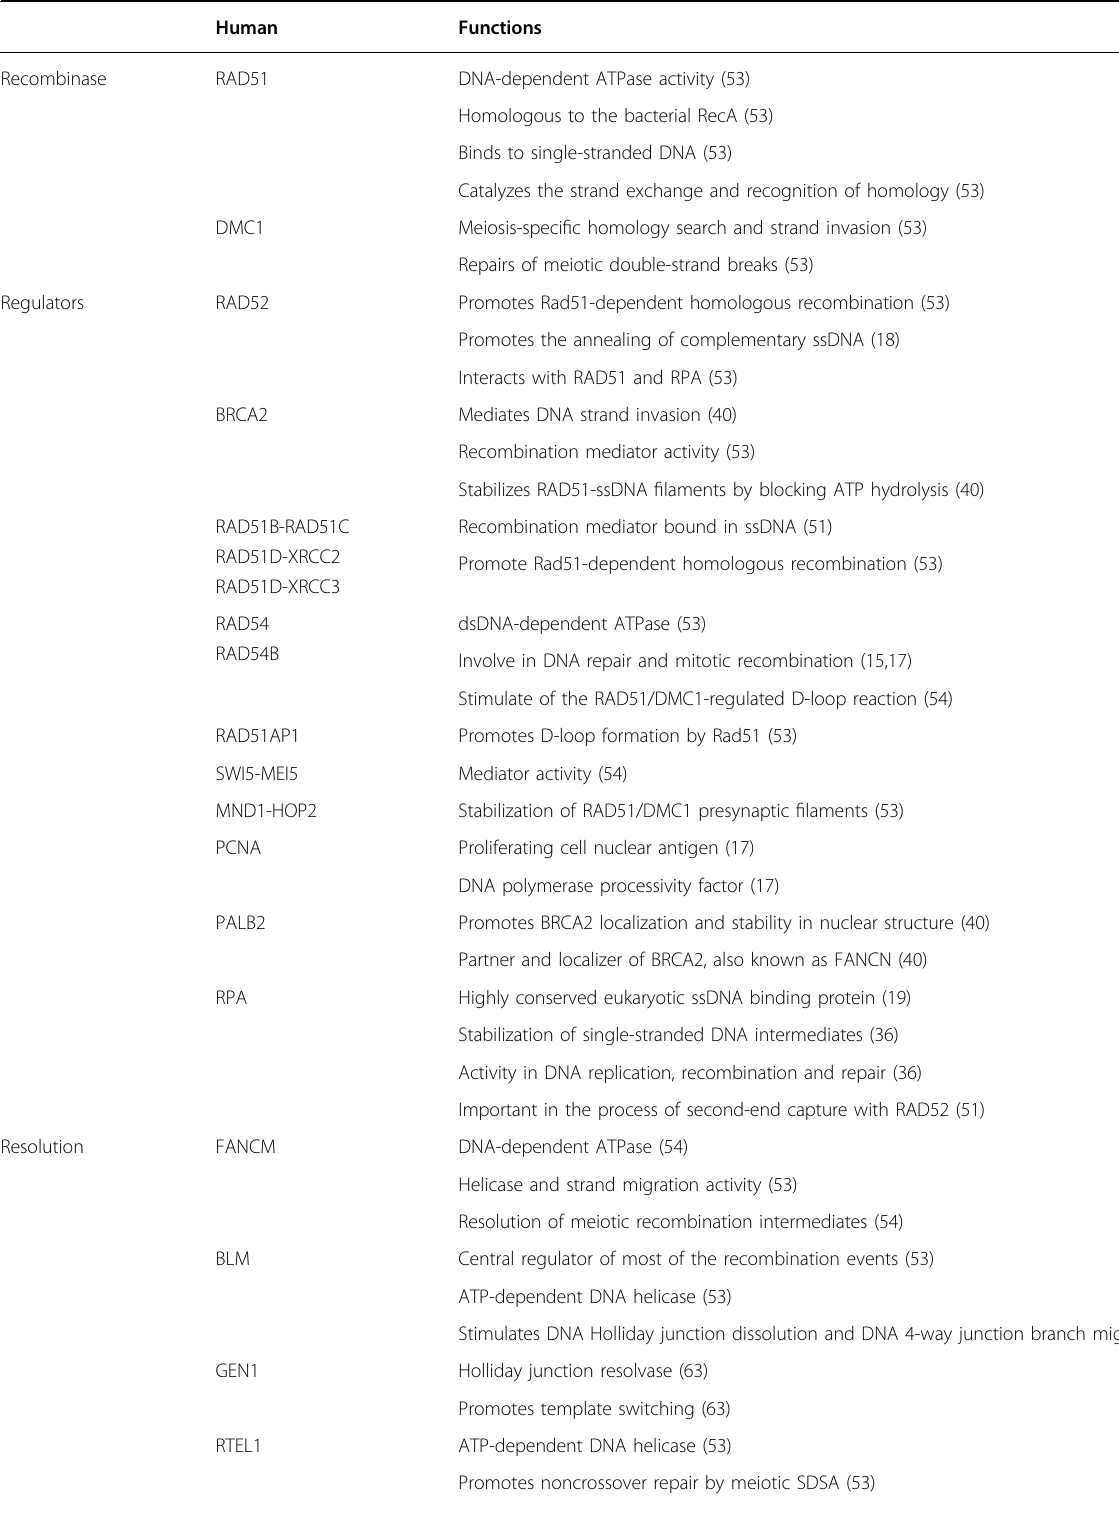
Table 2 Homologous recombination